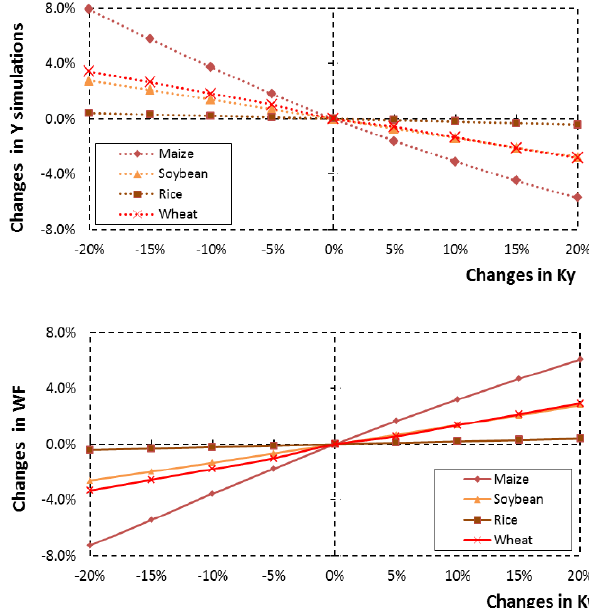
Figure 7. Sensitivity of Y and WF to changes in yield response factor ( K y ),